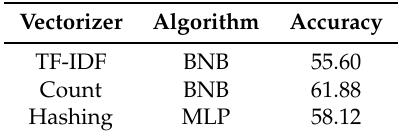
Table 8. Testing Score for Devanagari dataset.